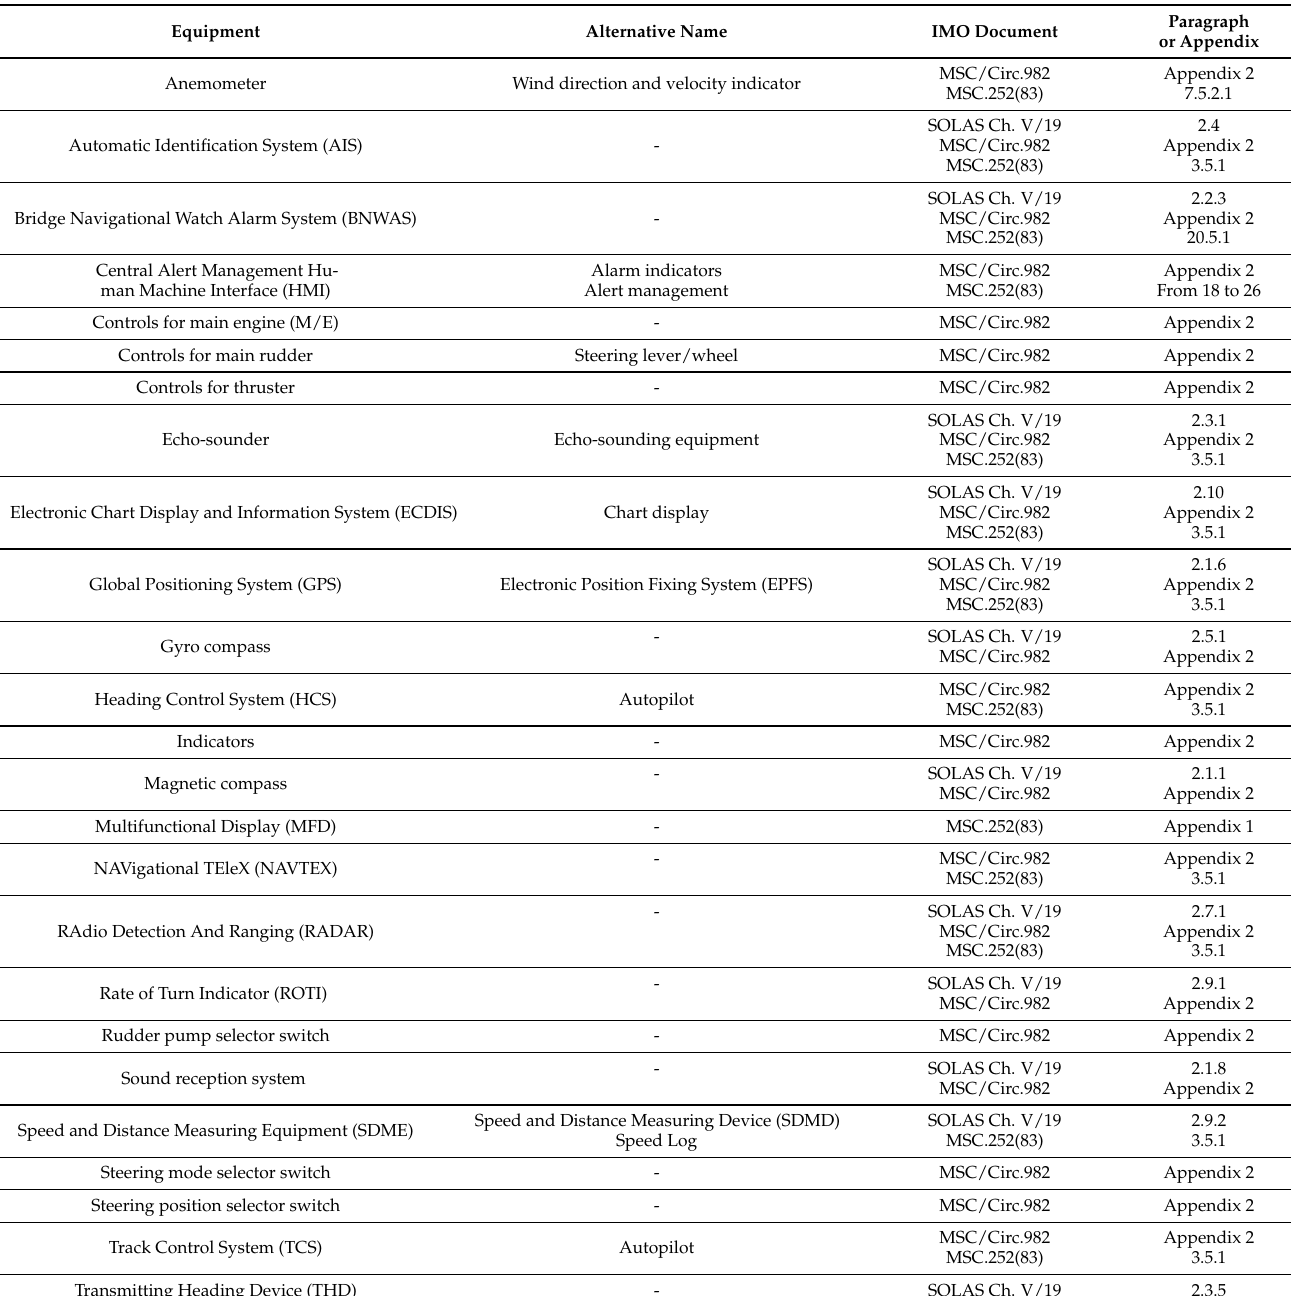
Table 2. Selected components of the INS (according to the